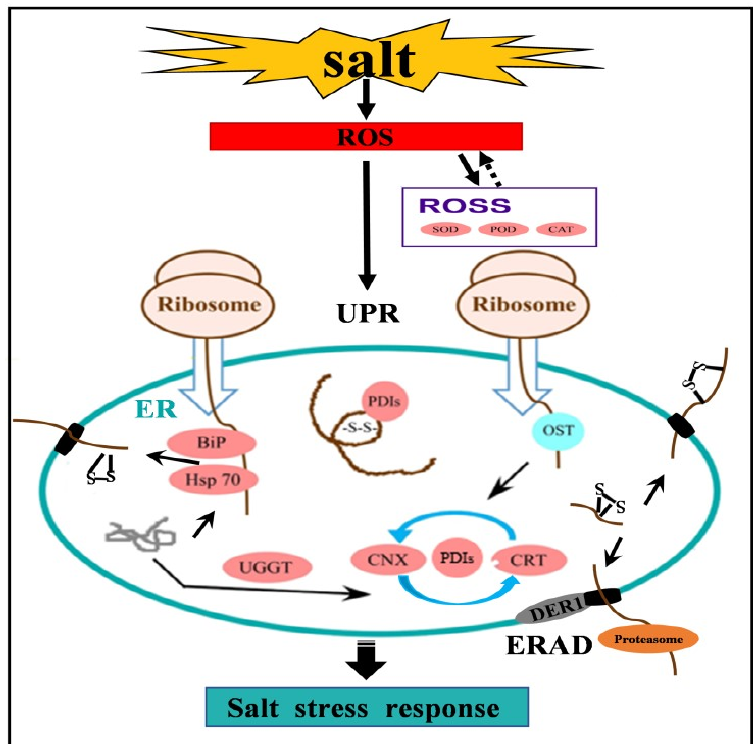
Figure 6. A putative synergistic responsive network of wheat ER proteome to salt stress. The red circle represents upregulated proteins. BiP , binding protein; CAT , catalase; CNX , calnexin; CRT , calreticulin; ERAD , endoplasmic reticulum associated degradation; DER1 , degradation in the endoplasmic reticulum protein 1; Hsp70 , 70 kilodalton heat shock proteins; ROS , reactive oxygen species; ROSS , reactive oxygen species scavenging; OST , oligosaccharide transferase; PDIs , protein disulfide ‐ isomerase; POD , peroxidase; SOD , superoxide dismutase; UGGT , UDP ‐ glycosyl transferases; UPR, unfolded protein reaction.